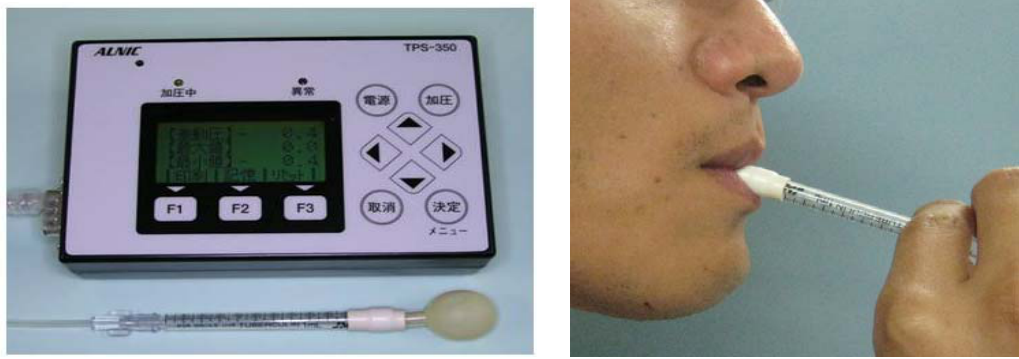
Figure 7. Disposable balloon probe system (photos courtesy of Dr. Kazuhiro Tsuga